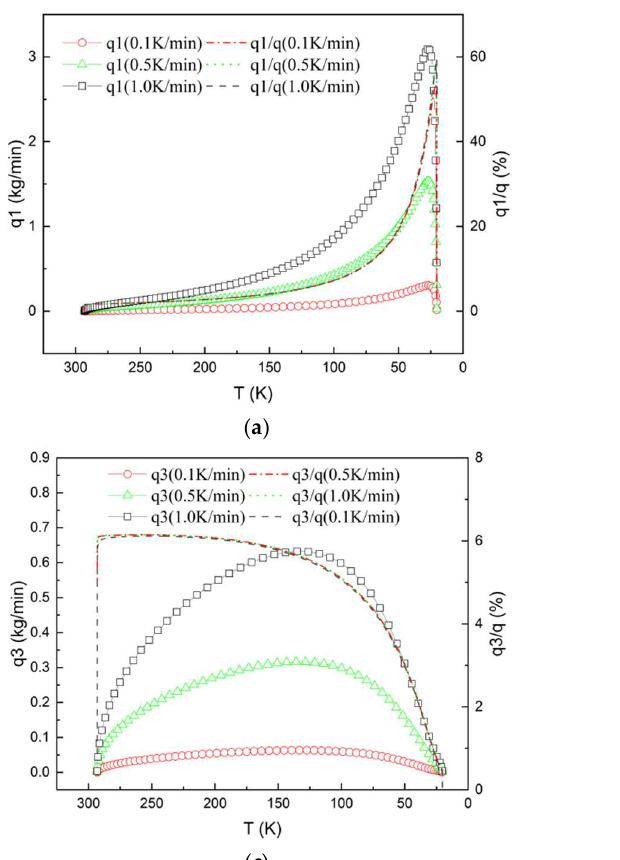
Figure 7. Total liquid hydrogen flows at different cooling rates. 4.2. Pre-Cooling Process Parameters at Different Cooling Rates Table 2 and Figure 8 show the pre-cooling time, the total mass of liquid hydrogen consumed, the proportions of the various heat loads, and the liquid hydrogen’s total flow at different cooling rates. The larger the average cooling rate, the shorter the pre-cooling time and the smaller the liquid hydrogen mass. Among the various heat loads, the pro- portion of liquid hydrogen consumption for offsetting heat leakage decreased with the cooling rate and that of the other three heat loads increased with the cooling rate. The cooling capacity of the inner tank wall and the accessories consumed the most significant